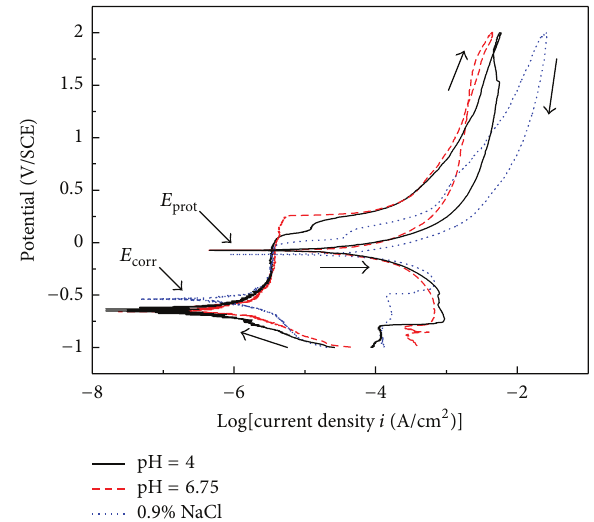
Figure 3: Polarization curves for composite arch wires in different solutions.